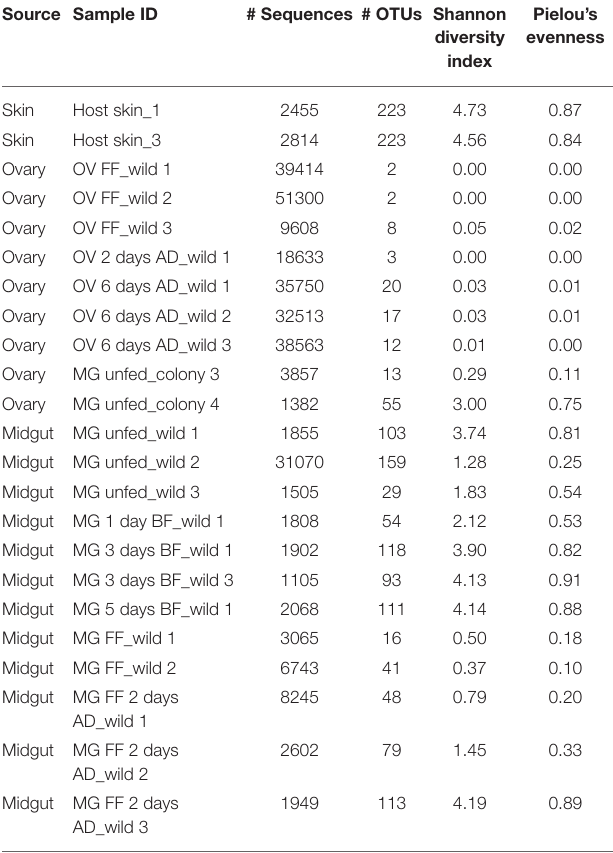
TABLE 2 | Number of good quality sequences and operational taxonomic units (OTUs), and alpha diversity indices of the bacterial community in the ovary and the midgut of Ixodes ricinus